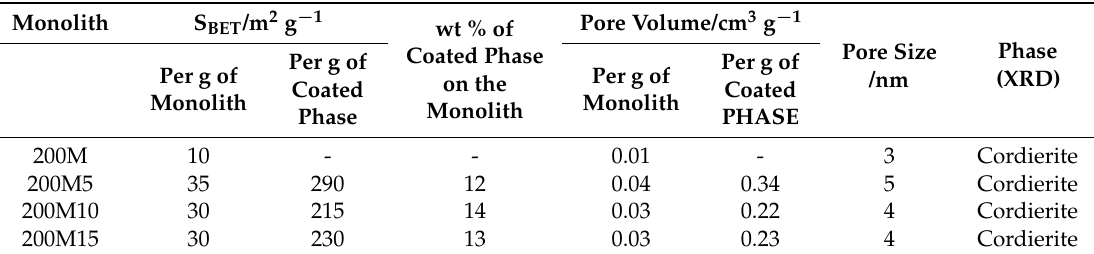
Table 4. Structural and textural properties of coated and uncoated monoliths (200M corresponding to the monolith treated with HNO 3 ).